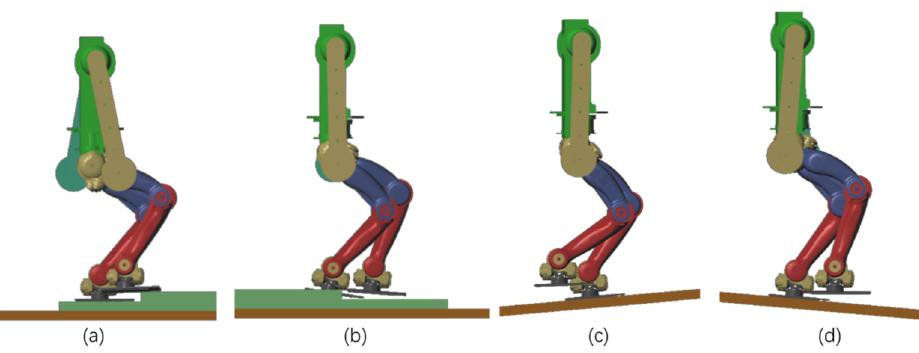
Figure 11. Walking on uneven ground: ( a ) Walking up stairs; ( b ) walking down stairs; ( c ) walking up